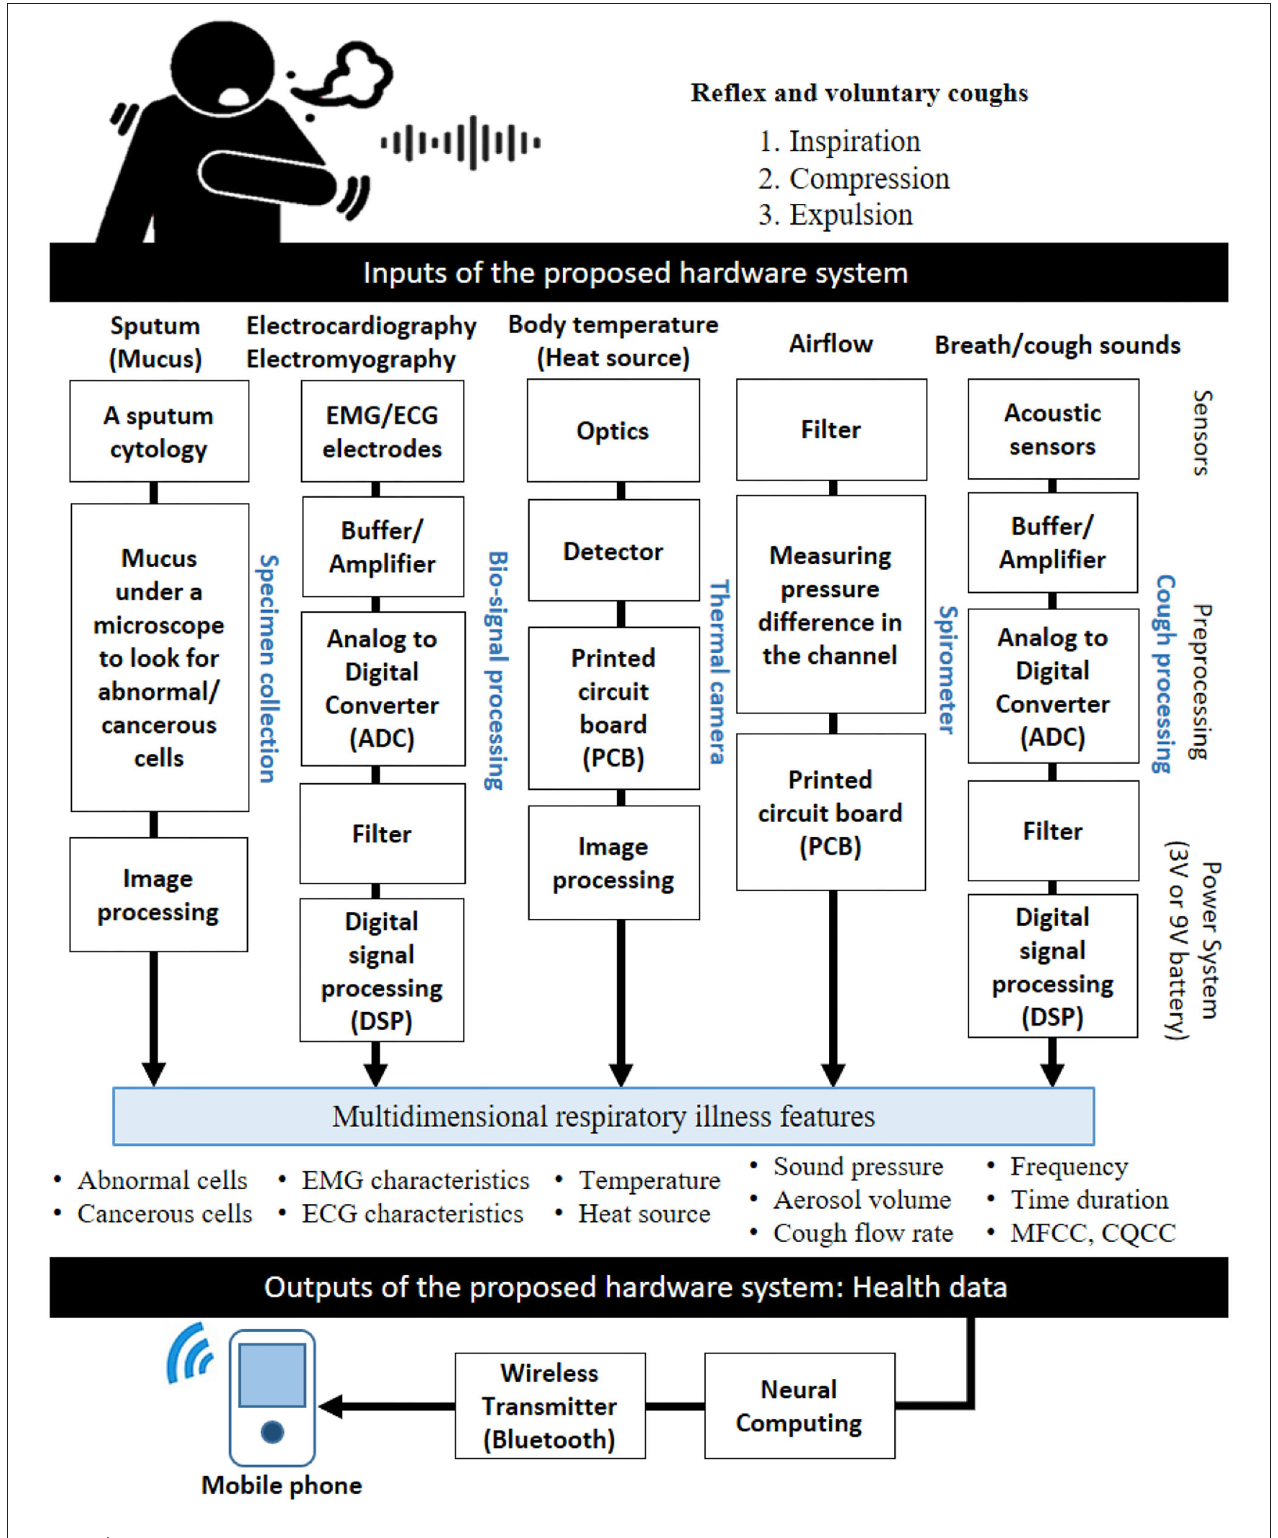
FIGURE 5 | Hardware architecture of our proposed low-cost system to collect health data. The hardware contains relevant sensors to measure some parameters, such as cough sound, breathing, body temperature, and so on to be translated to relevant health data (e.g., audio signal features commonly used in cough classification). Several sensors are needed to get relevant information from the human body (e.g., thermal camera, acoustic sensor, accelerometer, portable piezo contact microphone, airflow sensor, and EMG/ECG electrodes).